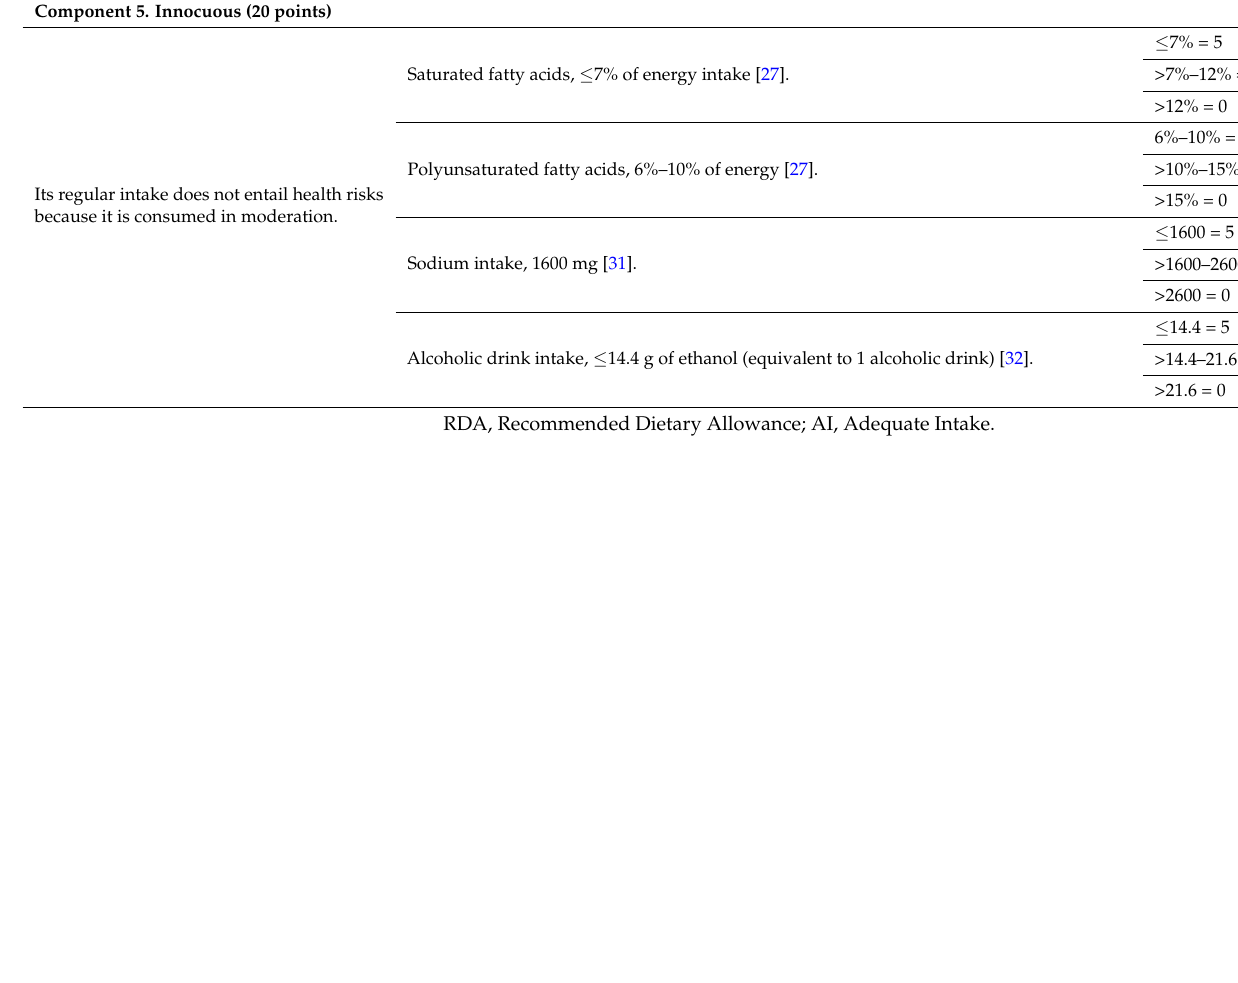
Daily Recommendation: Healthy Diet [11] Components of the ICDMx (Maximum: 100 Points) Scoring Criteria Component 5. Innocuous (20